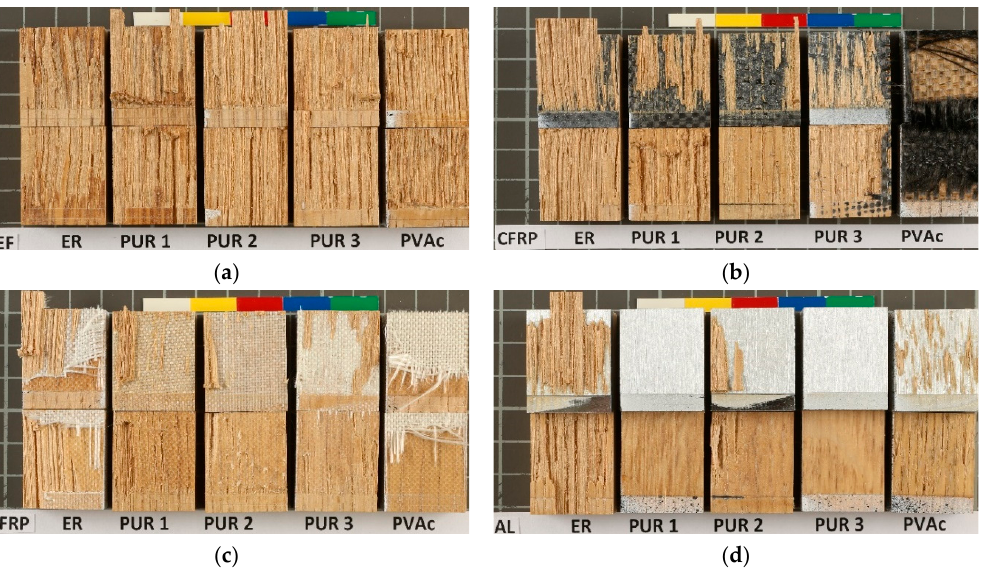
Figure 7. Failure mode of standard climatised samples ( a ) reference; ( b ) CFRP; ( c ) GFRP; ( d ) aluminium). (One square in the background surface is equivalent to 100 mm 2 .)